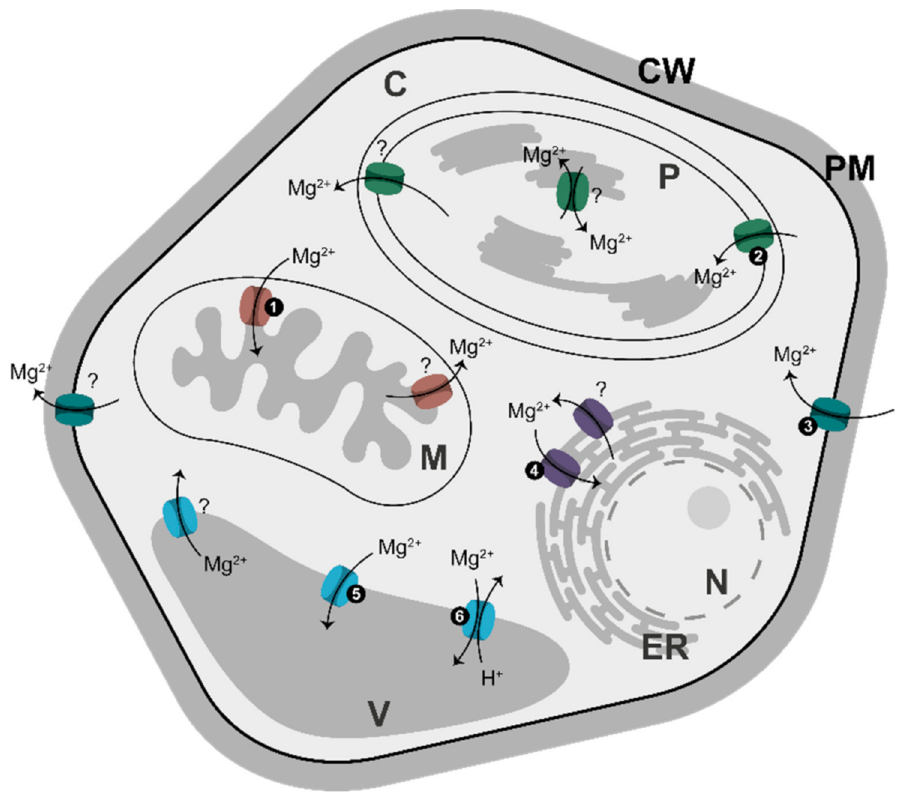
Figure 3. Distribution of Mg 2+ transporters in membranes in plants. All transporters shown here have been identified in Arabidopsis [83]. The light-grey area corresponds to compartments where AK equilibrium is established. Numbers correspond to: (1) MGT5; (2) MGT10; (3) MGT1, MGT5, MGT6, MGT9; (4) MGT4, MGT7; (5) MGT2, MGT3; and (6) MHX. Question marks refer to transporters involved in Mg 2+ export from a given compartment/cell; their nature remains unclear. Abbreviations: C, cytosol; CW, cell wall; ER, endoplasmic reticulum; M, mitochondrion; N, nucleus; P, plastid; PM, plasma membrane; V,